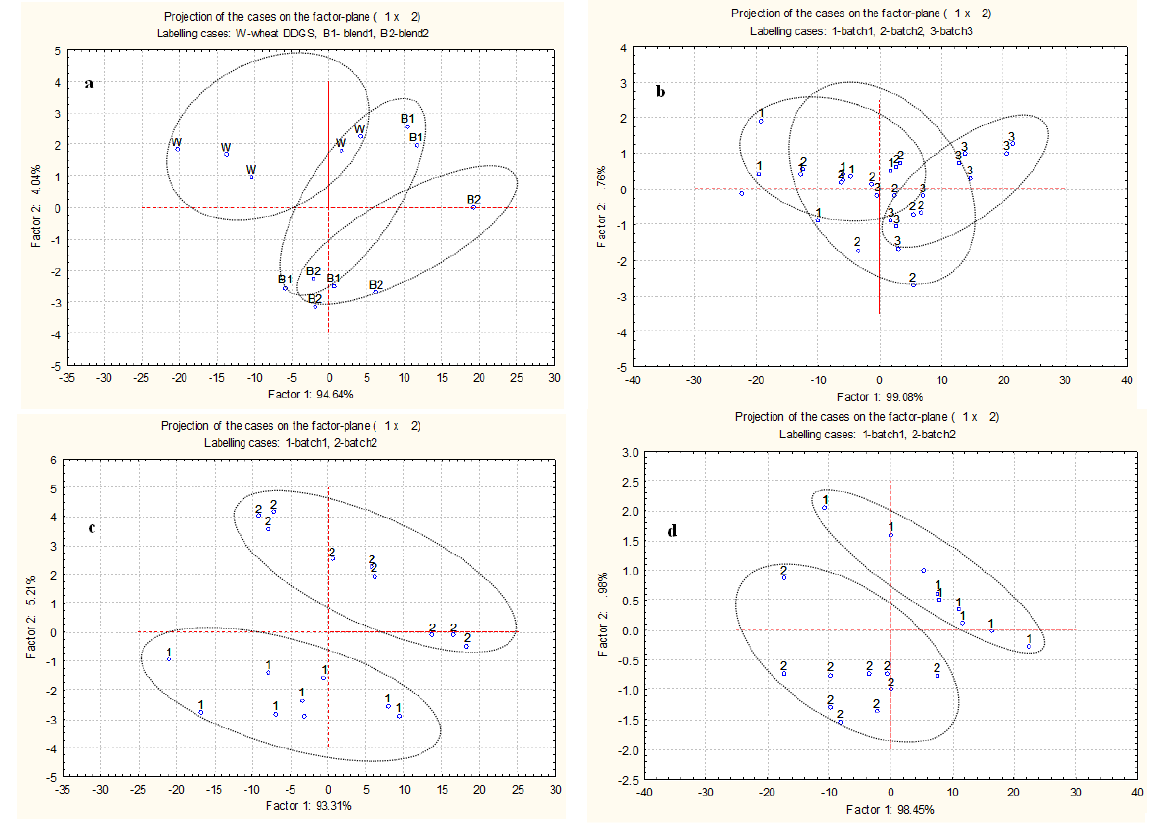
Figure 3. Principal component analysis with 1st vs. 2nd principal component of spectra from protein molecular structures in: ( a ) Wheat DDGS (W), BDDGS1 (B1; 30% corn and 70% wheat) and BDDGS2 (B2, 50% corn and 50% wheat); ( b ) Three batches within wheat DDGS; ( c ) Two batches within BDDGS1; and ( d ) Two batches within